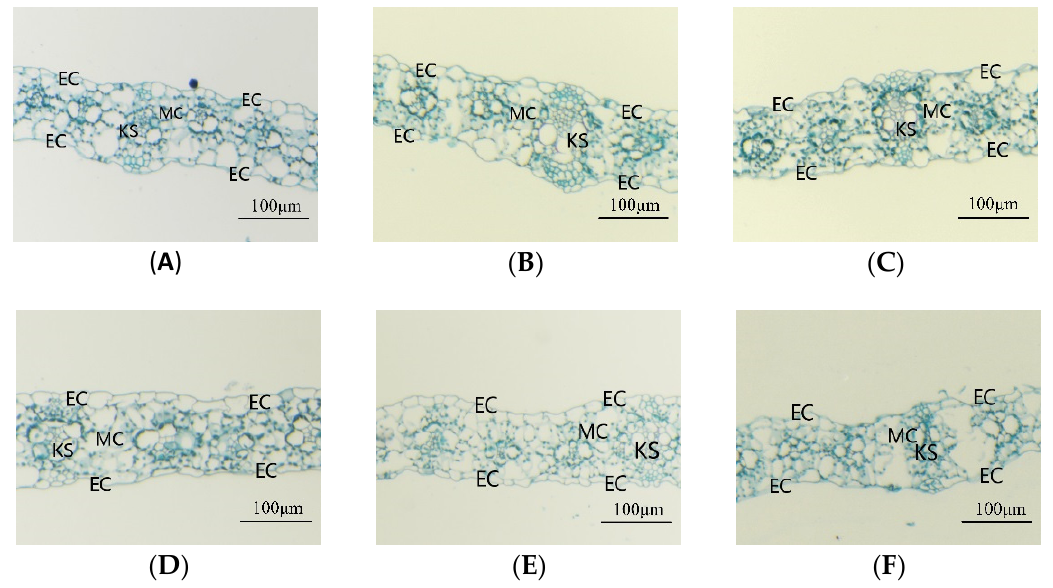
Figure 5. Effects of different root zone temperatures on the leaf microstructure of SD609 and SD902. ( A ) SD609 CK, ( B ) SD609 MT, ( C ) SD609 HT, ( D ) SD902 CK, ( E ) SD902 MT, ( F ) SD902HT. CK: 24 °C, MT: 30 °C, HT: 36 °C (root zone temperature). EC—epidermis cell, MC—mesophyll cell, KS—Kranz structures.